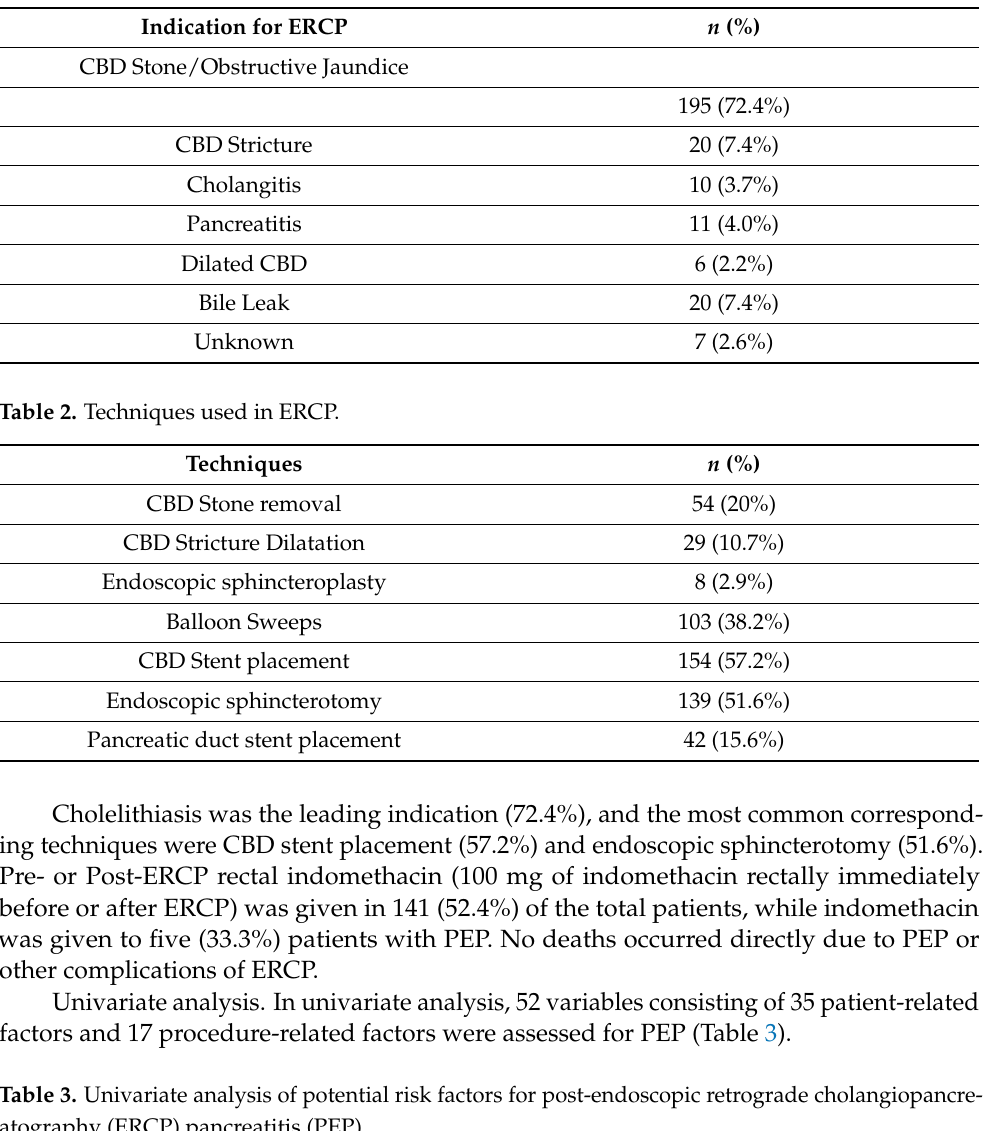
Table 1. Indications for endoscopic retrograde cholangiopancreatography (ERCP).